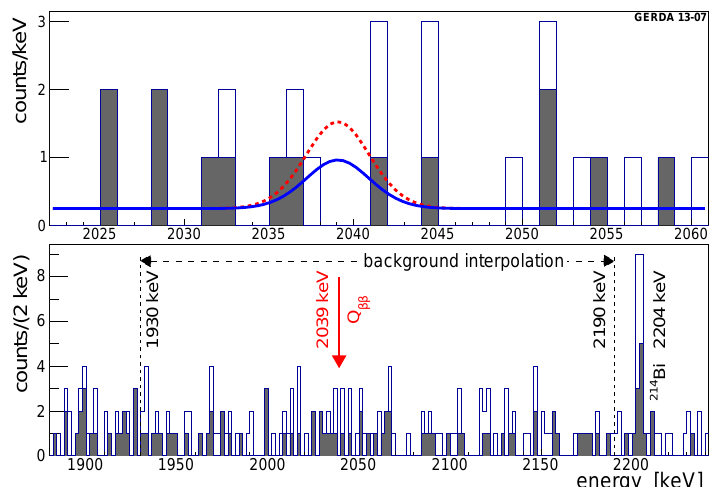
Figure 14. The combined energy spectrum from all enr Ge detectors without (with) PSD is shown by the open (filled) histogram. Top: the spectrum zoomed to Q ββ is superimposed with the expectations (with PSD selection) based on the central value of Reference [21], T 0 ν and with the 90% upper limit derived in this work, corresponding to T 0 ν Bottom: the energy region adopted for the background